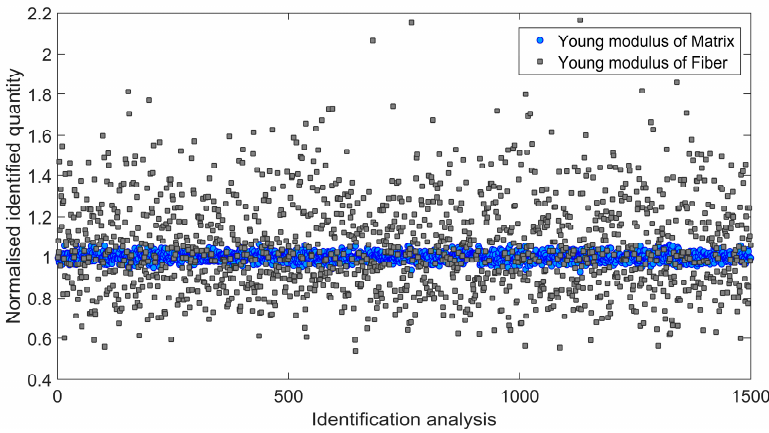
Figure 7. Normalized Poisson ratio of matrix and fiber identified during 1500 independent simulations involving standard deviation s 1 .